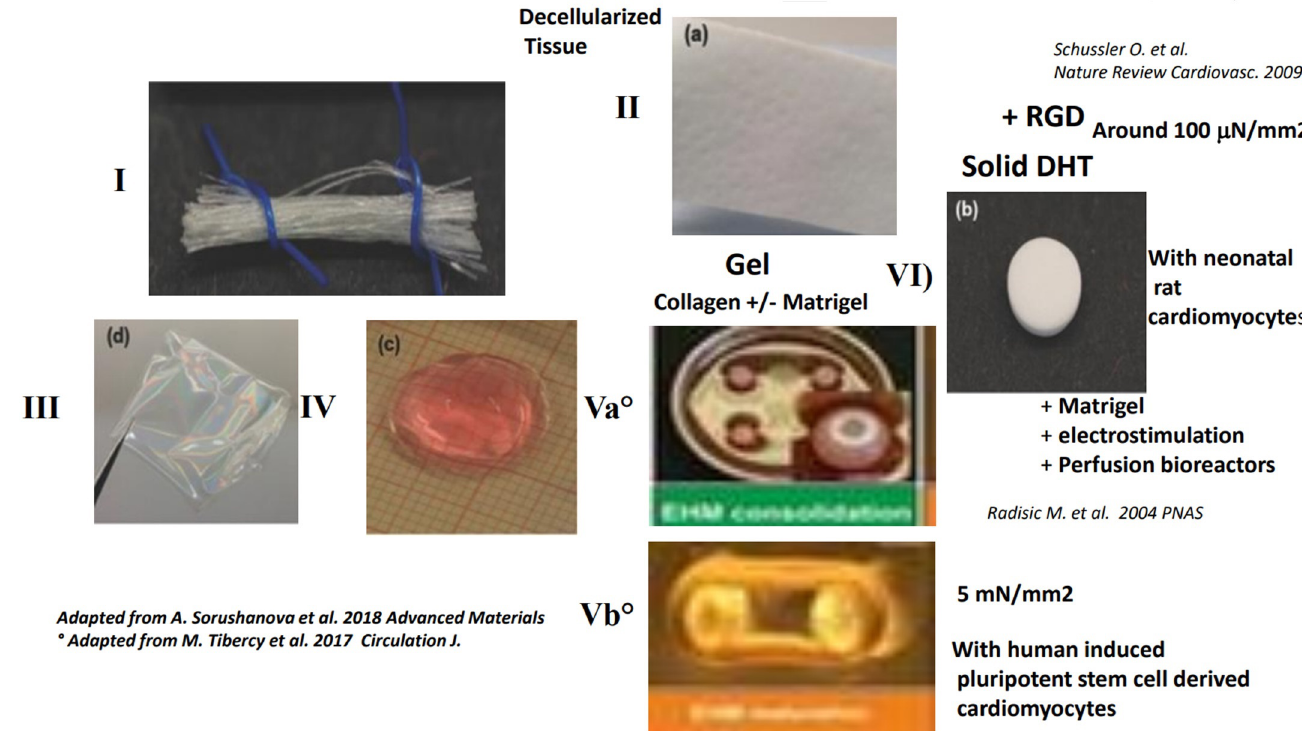
Figure 2. Several forms of collagen used in biomedicine to engineer a contractile tissue after seeding with contractile cells. Adapted from A. Sorushanova et al. Advanced Materials 2018 [16] and from M. Tiburcy et al. 2017 Circulation J. [108].